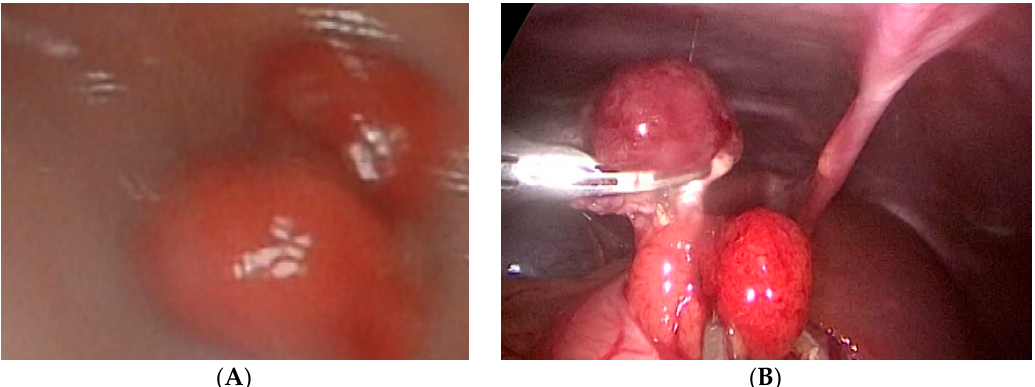
Figure 2. Endoscopic visualization of two polyps and laparoscopic polypectomy. ( A ) After having polyps endoscopically visualized; ( B ) A double polypectomy was made using an ultrasonic knife.